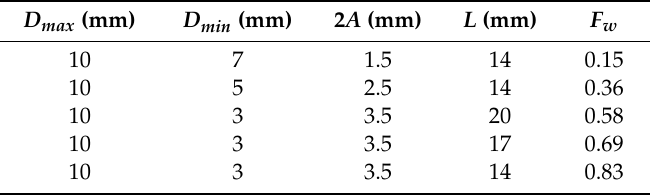
Table 1. Dimensions of wavy-walled tubes.